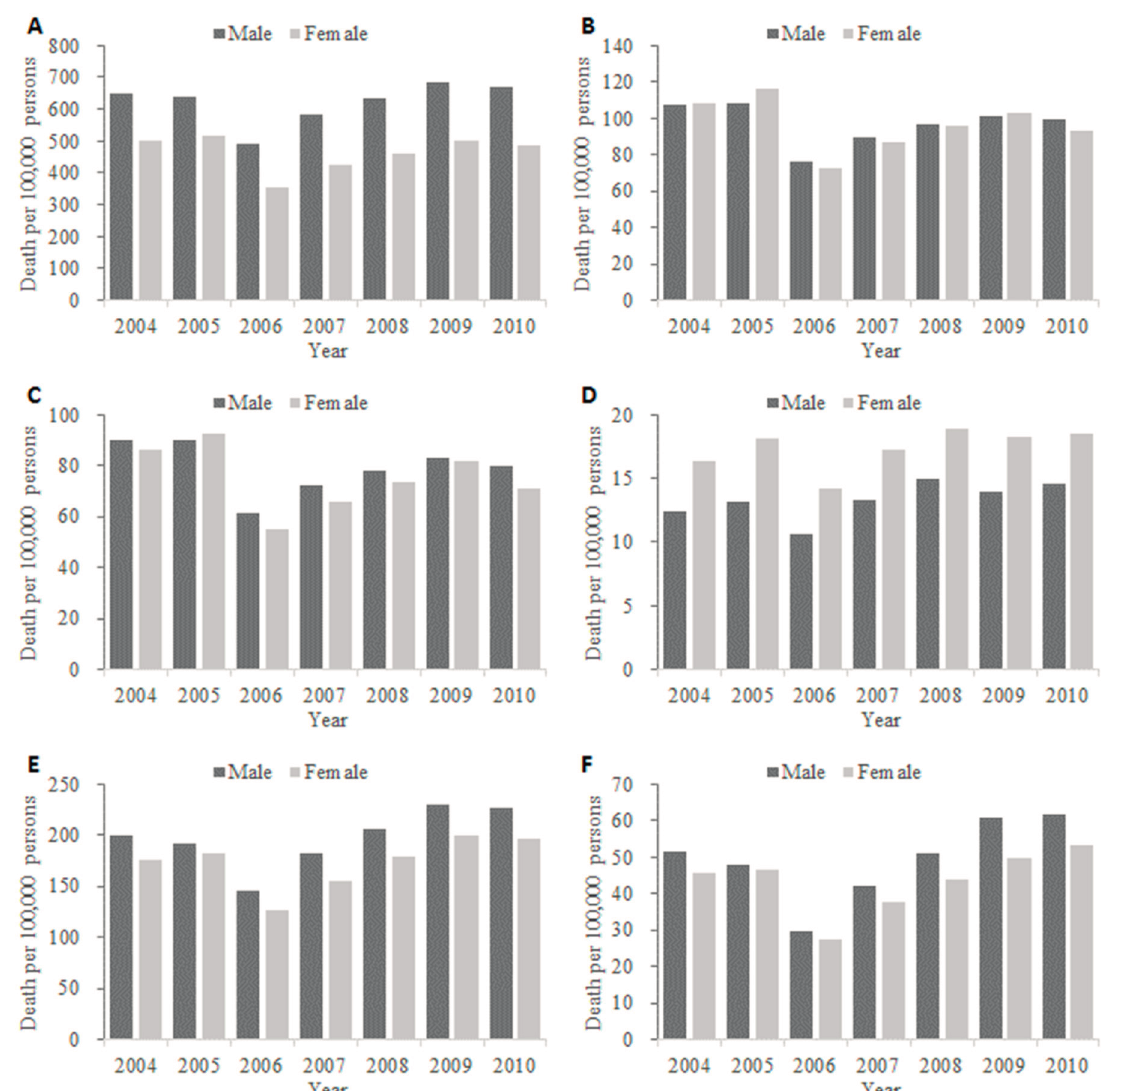
Figure 2. Average mortality rates by death cause and sex in Southern China,